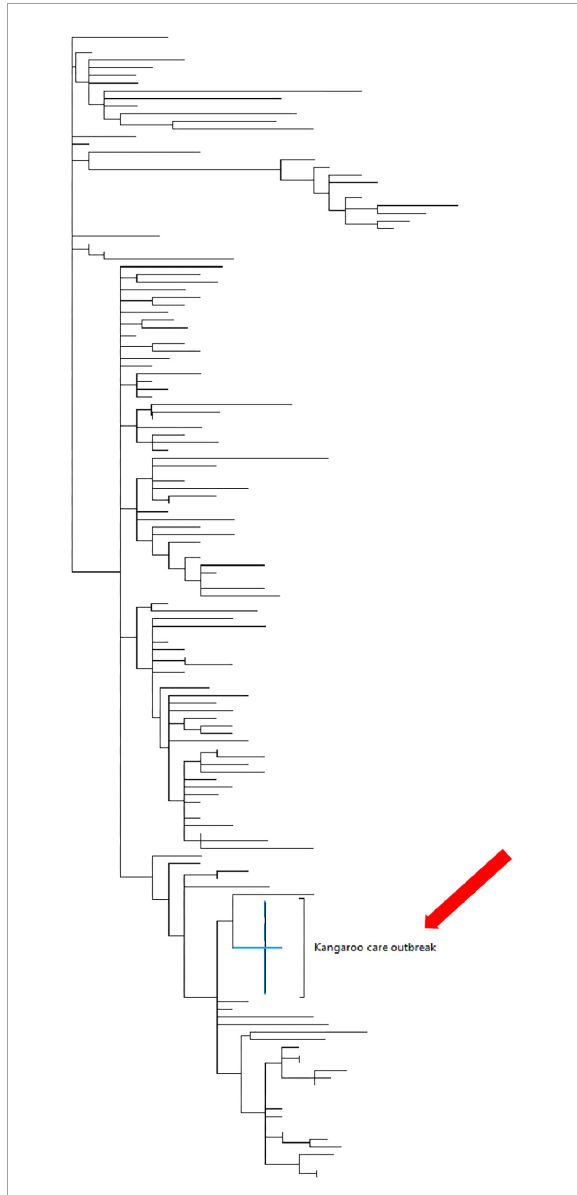
FIGURE2 The maximum clade credibility phylogeny of the mother and babies who tested positive during the outbreak in the Kangaroo care ward. Phylogenetic tree of 160 genomes collected in SA during the time that the outbreak had occurred. The maximum clade credibility phylogeny of the mothers and neonates who were tested during the outbreak in the KMC ward (red arrow). This indicates that the genomic data obtained from the 10 mothers and 3 neonates were clustered closely